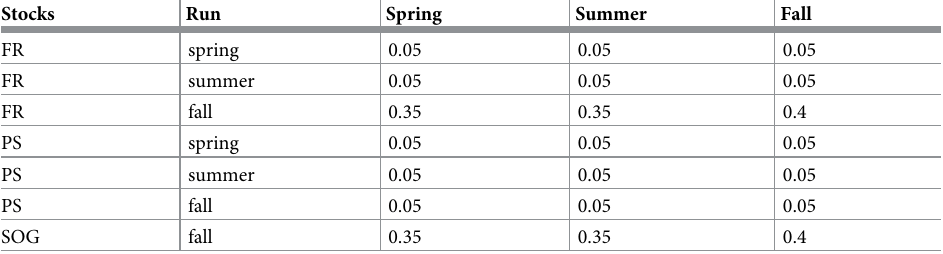
Table 2. Estimated seasonal proportions P i , s , a , y , A of the fall and spring and summer runs immature Chinook salmon residing in the Salish Sea. Stocks